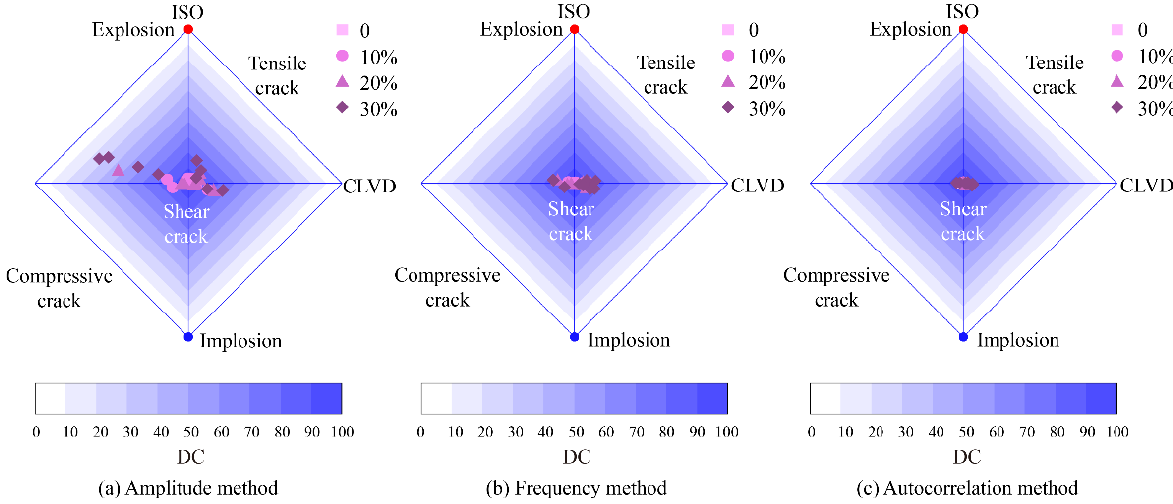
Figure 8. The source-type plots of the inversion results for shear cracks calculated by the three meth- ods.